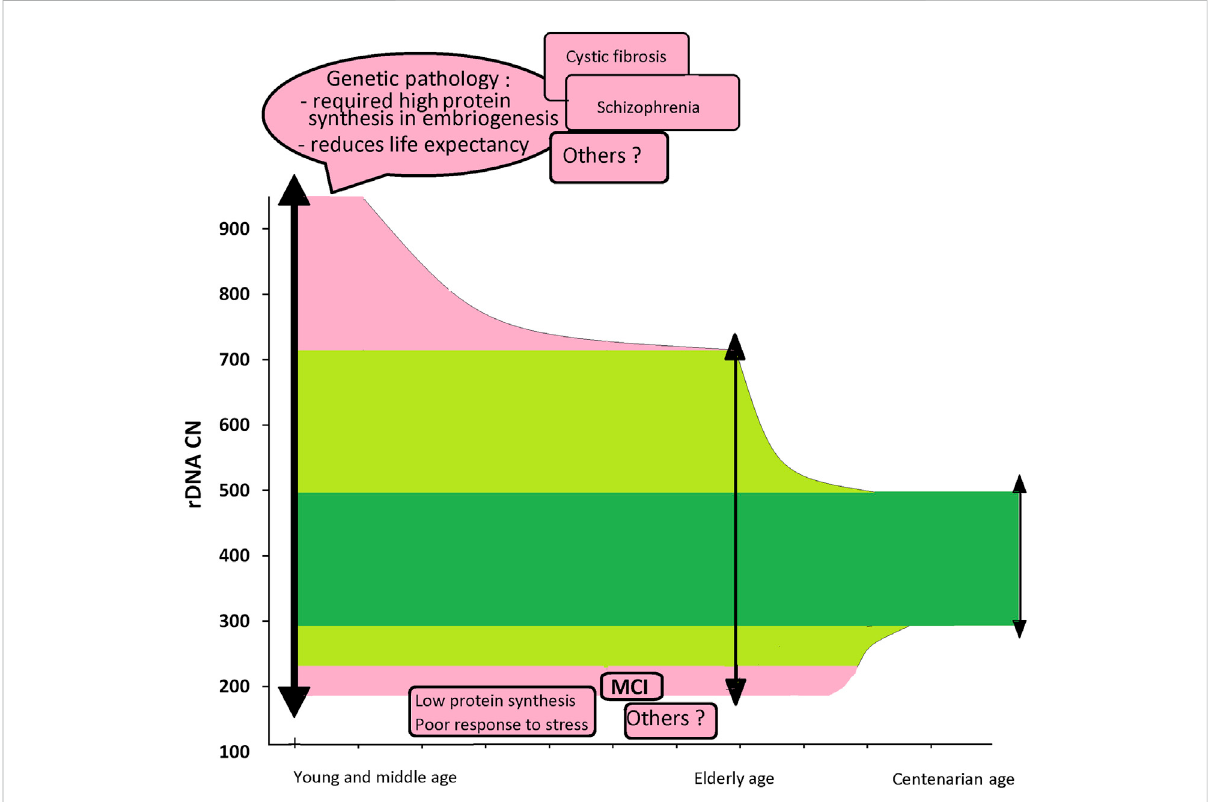
FIGURE 4 A diagram summarizing our data associating rDNA CN in the human genome with factors affecting life expectancy. A population of children: rDNA CN varies from 180 – 200 to 900 – 950. The distribution of DNA samples from the children whose genome contains mutations associated with life-shortening diseases is shifted towards high rDNA CN values. The elderly population (60 – 90y): rDNA CN varies from 200 – 220 to 500 – 700. The subpopulation of sick children who live to old age does not contain DNA samples with a large rDNA CN. Centenarians: rDNA CN varies in a narrow range from 300 to